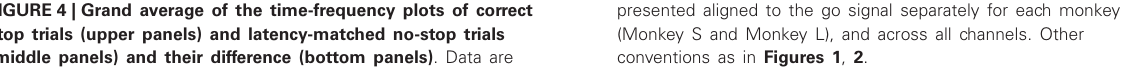
presented aligned to the go signal separately for each monkey (Monkey S and Monkey L), and across all channels. Other conventions as in Figures 1 , 2